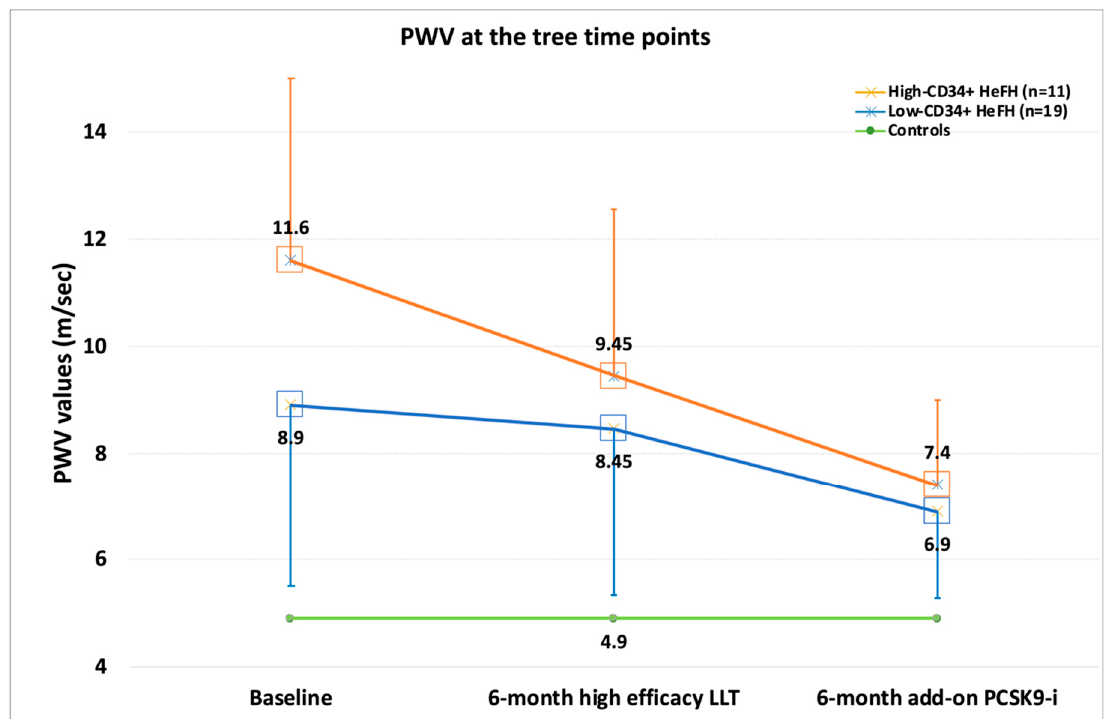
Figure 2. PWV values at the three scheduled time points in the low-CD34+ cell group and the high-CD34+ cell group; IQR is represented by error bars. Green line represents baseline PWV median value in